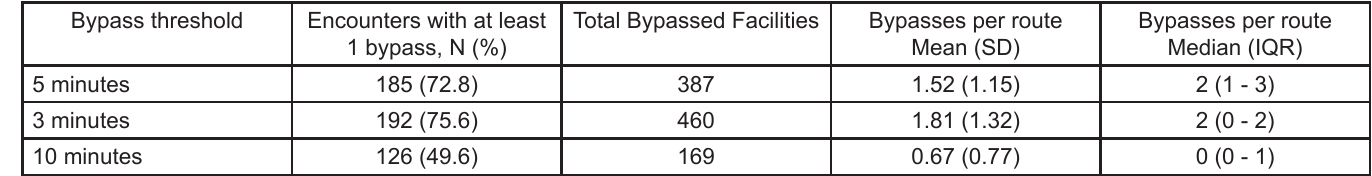
Table 1. Bypass incidence for pediatric asthma emergency medical services encounters.